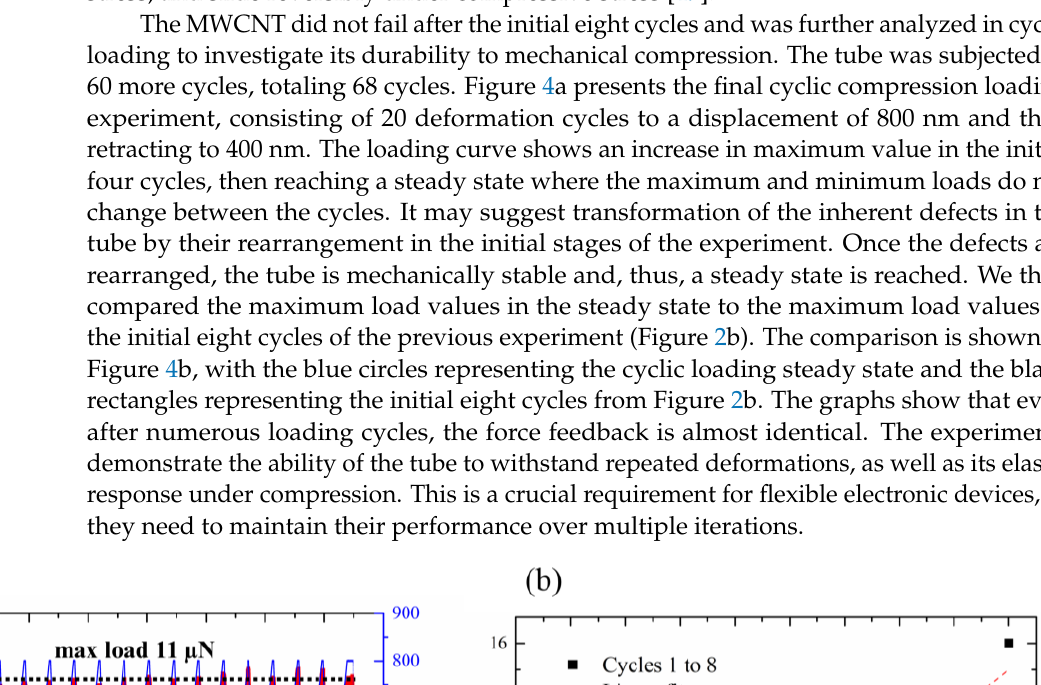
6 of 12 Figure 3. ( a ) Load – displacement curves of eight consecutive compression cycles under axial loading and relaxation. The graph shows increasing displacements and loads for each cycle with a hystere- sis. The critical load for buckling ( P cr ) is identified in the load – displacement curves and was used to calculate the modulus via Euler ’s column formula. ( b – d ) Snapshots and the corresponding F – D